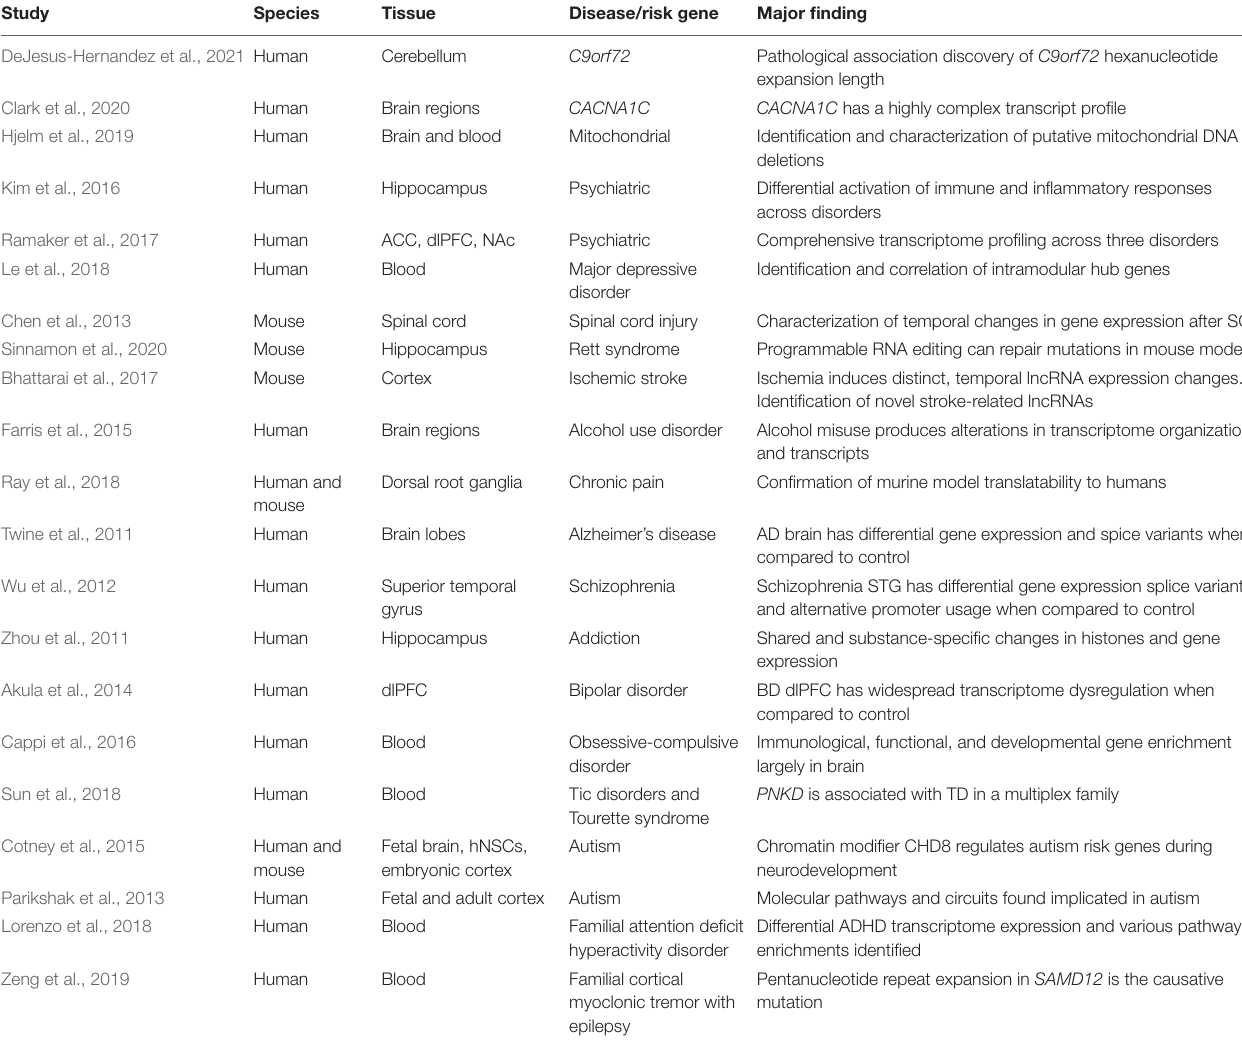
TABLE 1 | A selection of studies using NGS to study brain function and